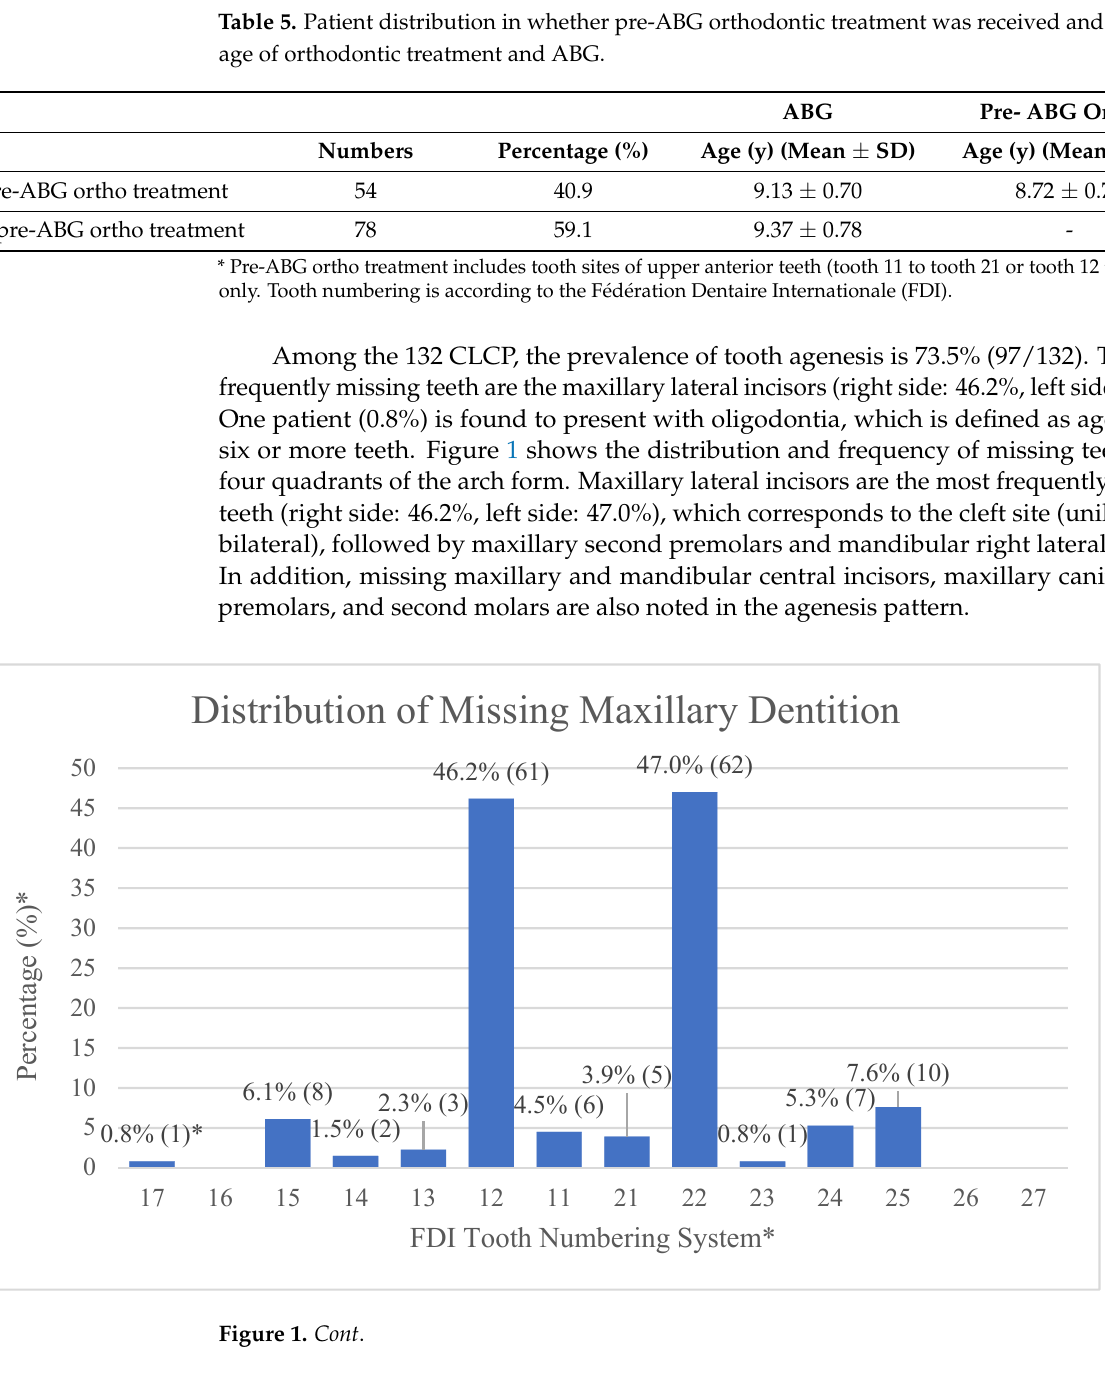
Table 5. Patient distribution in whether pre-ABG orthodontic treatment was received and the mean age of orthodontic treatment and